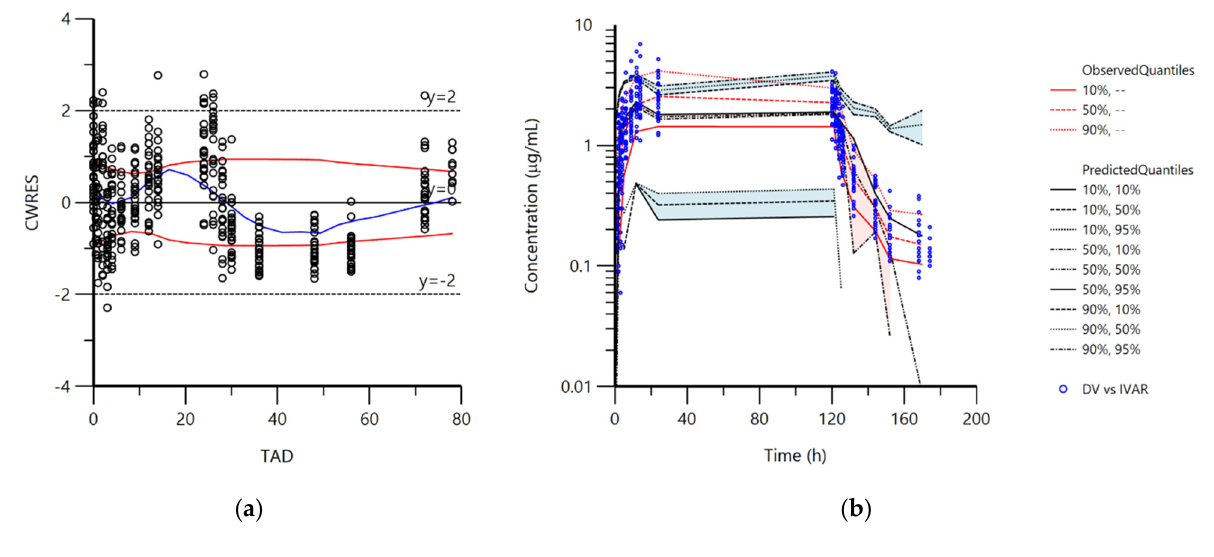
Figure 1. ( a ): Plot of conditional weighted residual values (CWRES) versus time after dose (TAD, h); <20% of values (3.46%) were outside the accepted limits y = 2 and y = − 2, demonstrating adequate description of changes in concentrations by the pharmacokinetic model. ( b ): Visual predictive check (VPC) plot depicting the observed quantiles (10, 50, and 90%) and corresponding predicted quantiles for doxycycline concentrations.